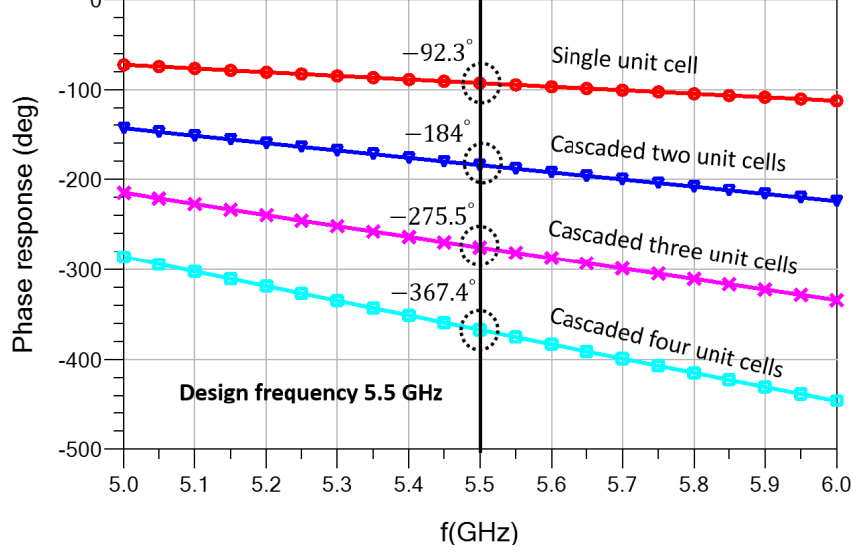
Figure 7. Simulated phase response results of the proposed unit cell and cascaded unit cells P-CRLH phase shifter with MRSs embedded on the symmetrical stubs for −90 ° phase shift.